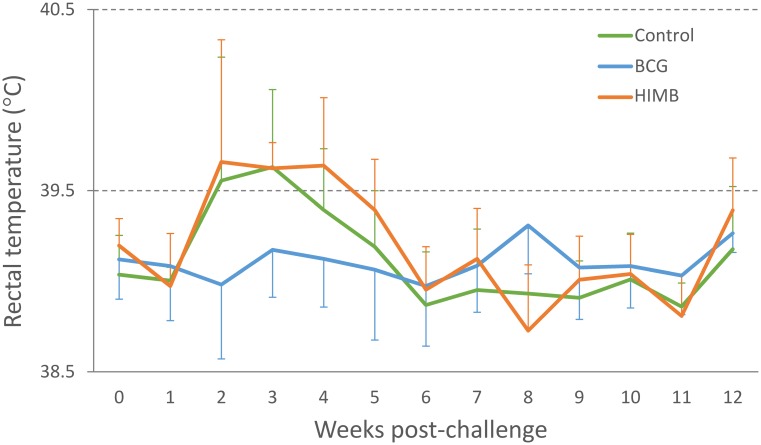
Rectal temperature after M. caprae challenge.Results are expressed as mean temperature (°C) ± 95% confidence interval (CI) in unvaccinated control (n = 6), BCG vaccinated (n = 6) and HIMB vaccinated (n = 6) lambs.